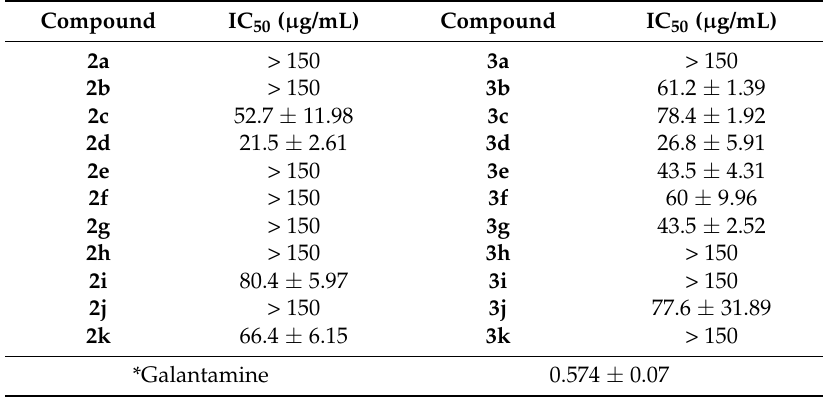
Table 2. Acetylcholinesterase inhibitory activity of synthesized compounds 2a – 2k and 3a – 3k .